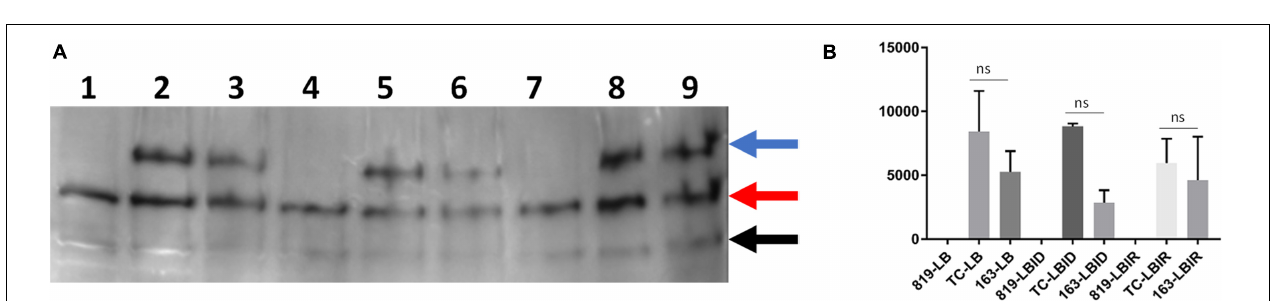
FIGURE 4 | Virulence gene expressions of S. enterica were upregulated in iron-depleted conditions compared to iron-rich. Quantitative reverse transcription-PCR (qRT-PCR) was performed using SYBR green assays on six genes cvaC , iss , sitA , iutA, enolase, and iucA. The data in the figure depicts the transcription level of either strain SE426 (A) or strain SEN032 (B) . Both strains were grown for 4 h in LBID or LBIR media. The 0 h control was grown on LB and served as the baseline expression level of tested genes. Two biological replicates and three technical replicates were used for each sample ( ± SD). Gene expression was normalized by gmk and adk reference genes. Student’s t -test was performed between control vs. iron rich; control vs. iron depleted; iron depleted vs. iron rich with data being considered significant when p < 0.05. Asterisk ( ∗ ) indicates statistically significant difference between expression of genes at iron depleted as compared to iron rich condition.